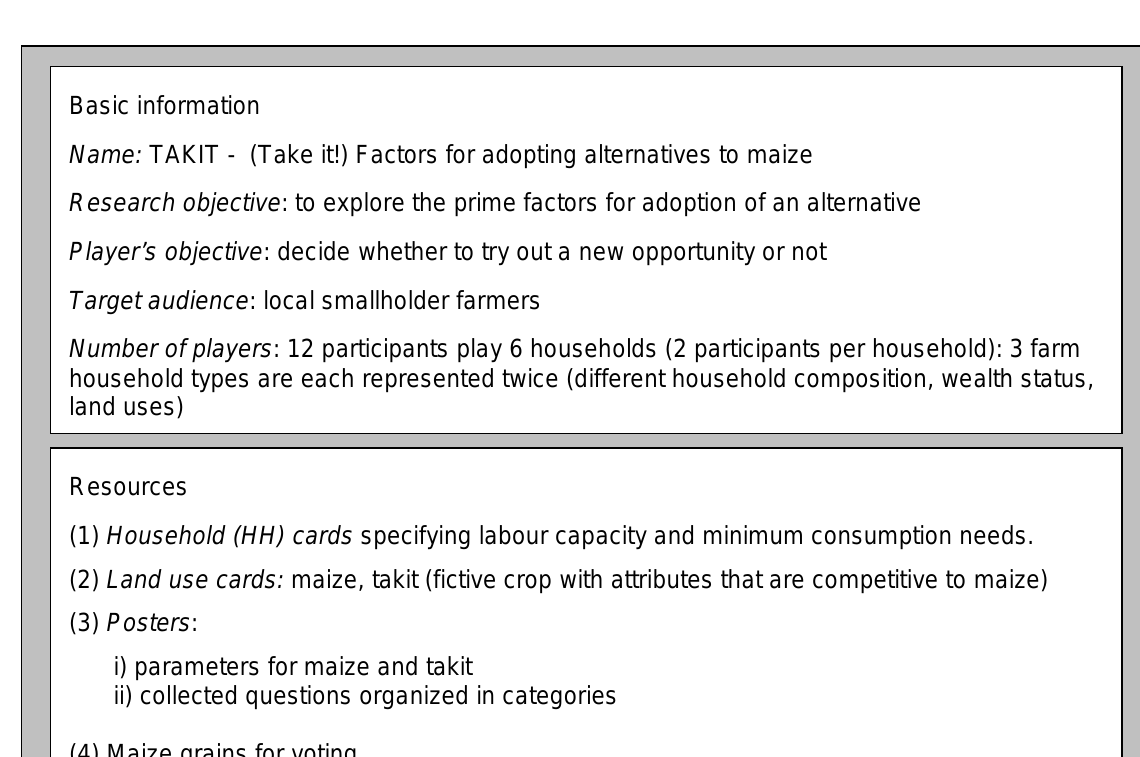
Figure A.2.6. Description TAKIT Workshop developed in Namgnang